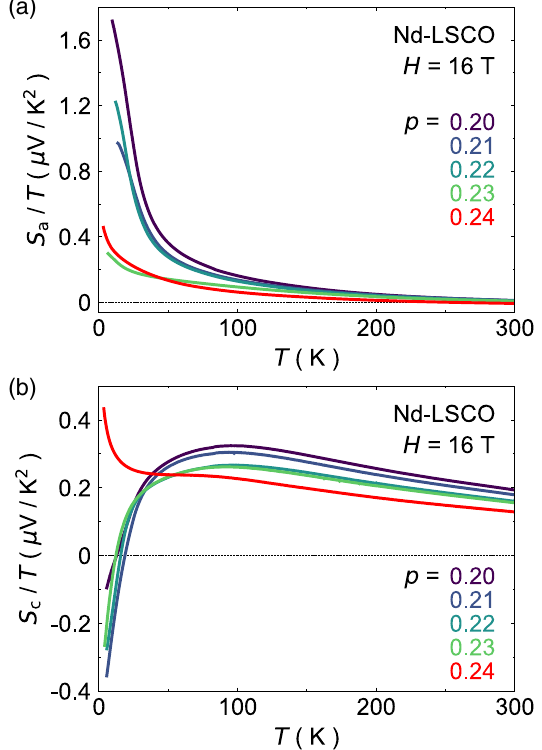
FIG. 4. (a) S a =T and (b) S c =T as a function of the temperature, at H ¼ 16 T, in Nd-LSCO at dopings as indicated, on both sides of the pseudogap critical point p ⋆ ¼ 0 . 23 . Note the qualitative change in S c upon crossing below p ⋆ , whereby S c suddenly becomes negative at low T .